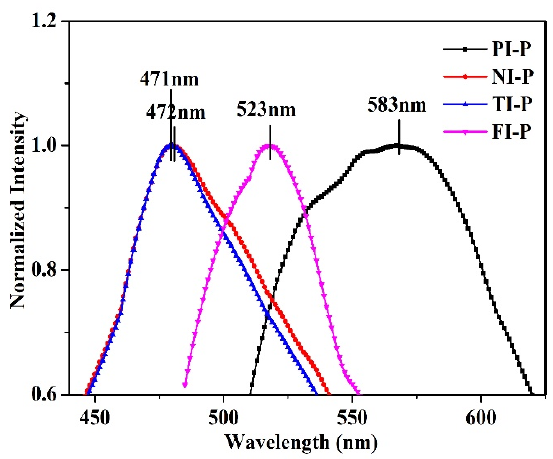
Figure 2. Solid-state photoluminescence (PL) spectra ( λ ex = 365 nm) for PI-P , NI-P , TI-P and FI-P.